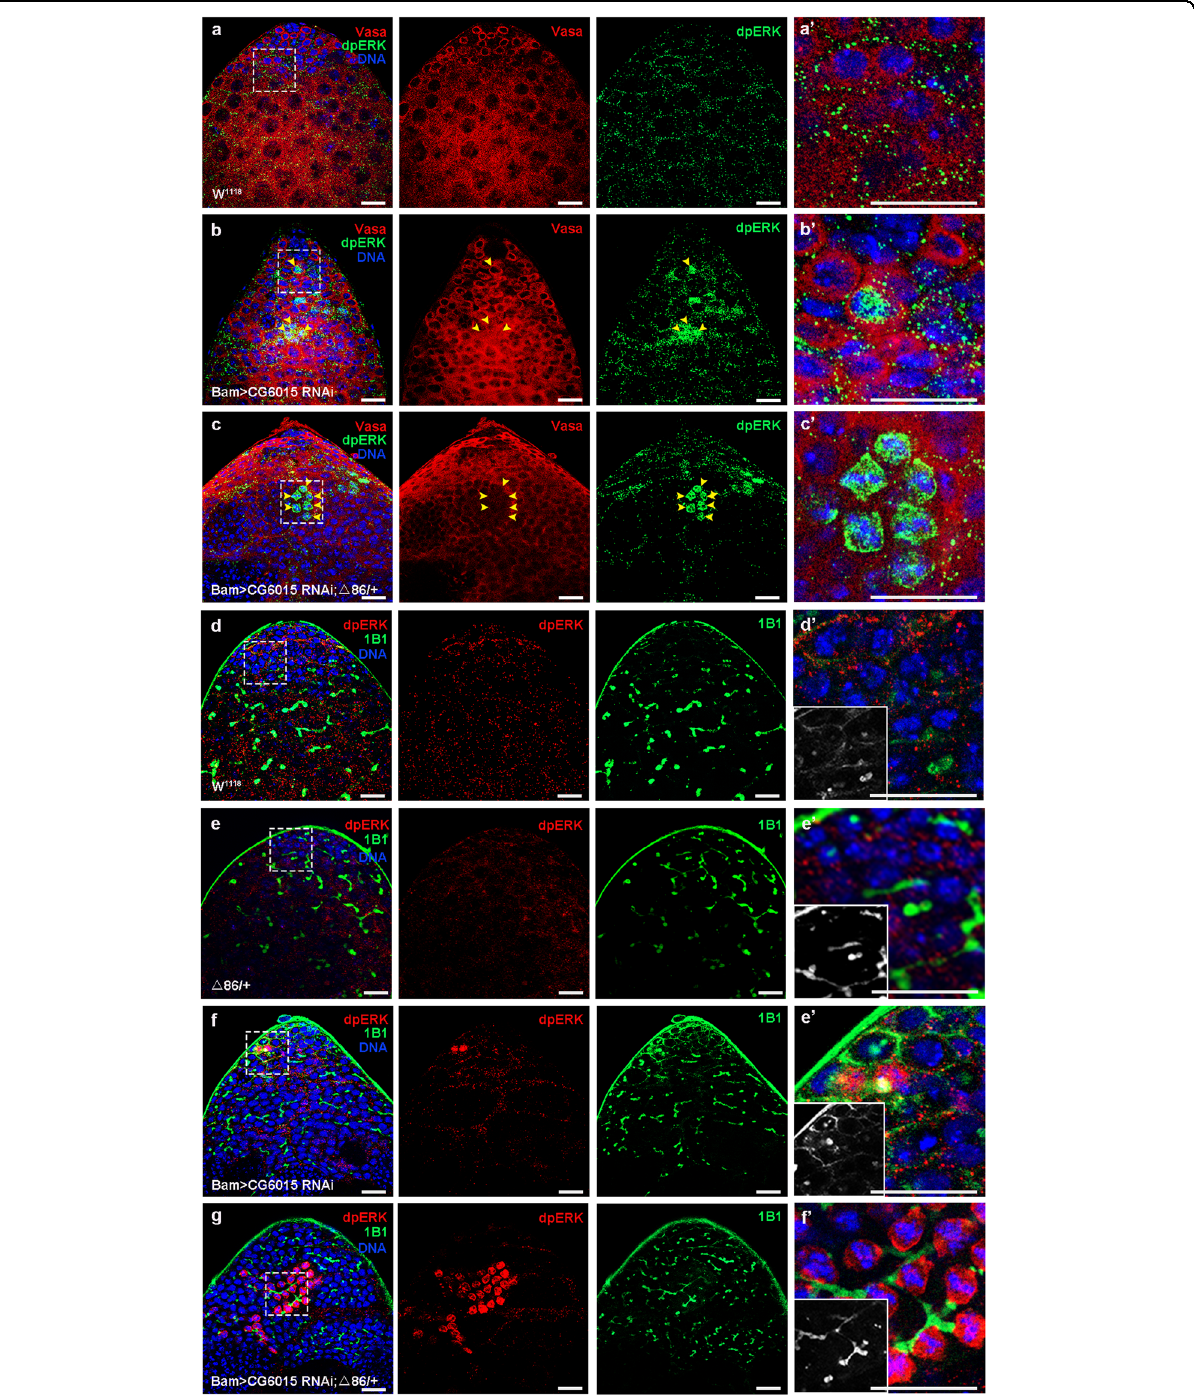
Fig. 6 Reduction of CG6015 in spermatogonia upregulated dpERK in GSC-like cells. a – c Immunostaining of dpERK (green) and Vasa (red) at the apex of W 1118 , Bam> CG6015 RNAi, and Bam> CG6015 RNAi; Δ 86/ + testes. Representative germline dpERK signals are shown by using yellow arrowheads. a ’ – c ’ Enlargements of the immunostaining of dpERK and Vasa signals. d – g Immunostaining of dpERK (red) and 1B1 (green) at the apex of W 1118 , Δ 86/ + , Bam> CG6015 RNAi and Bam> CG6015 RNAi; Δ 86/ + testes. d ’ – g ’ Enlargements of immunostaining of dpERK and 1B1 signals. DNA was stained with Hoechst (blue). Scale bars: 20